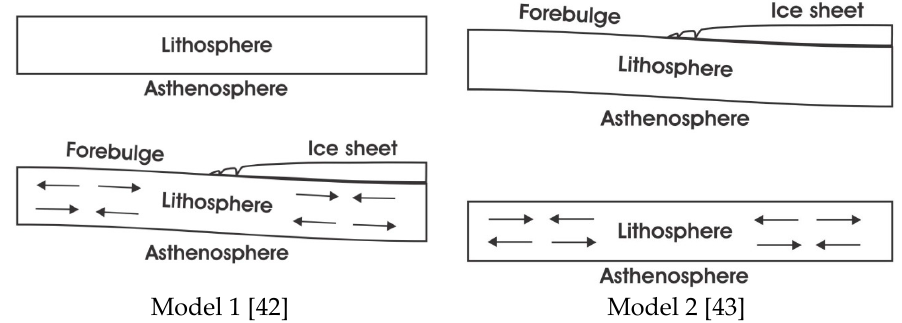
Figure 4. Left : Flexural stress model ([42]) assuming crustal stress equilibrium prior to the ice load. The resulting stresses are large during loading and diminish during unloading. The resulting stress state is compressional beneath the ice sheet and extensional in the hinge zones. Right: Flexural stress model ([43]) assuming crustal stress equilibrium after a period of ice loading. From [28].